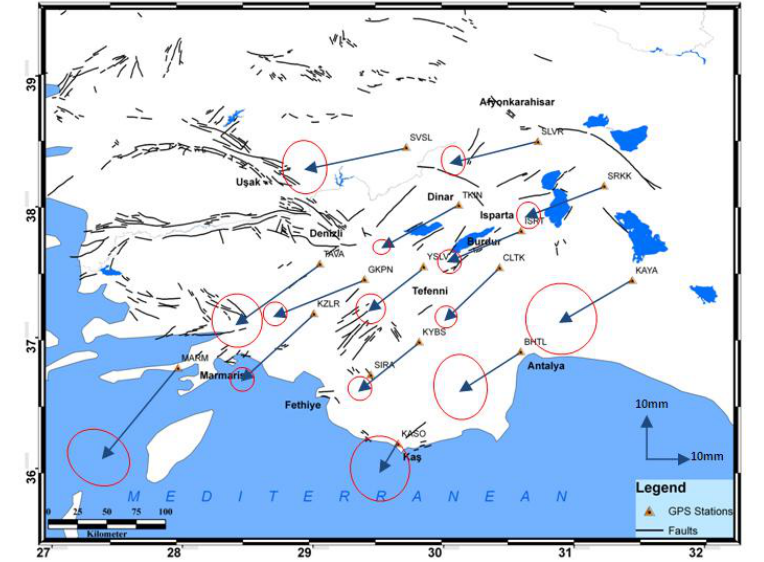
Figure 4. Horizontal velocity field in the Eurasia-fixed frame (ellipses are at 95 % confidence